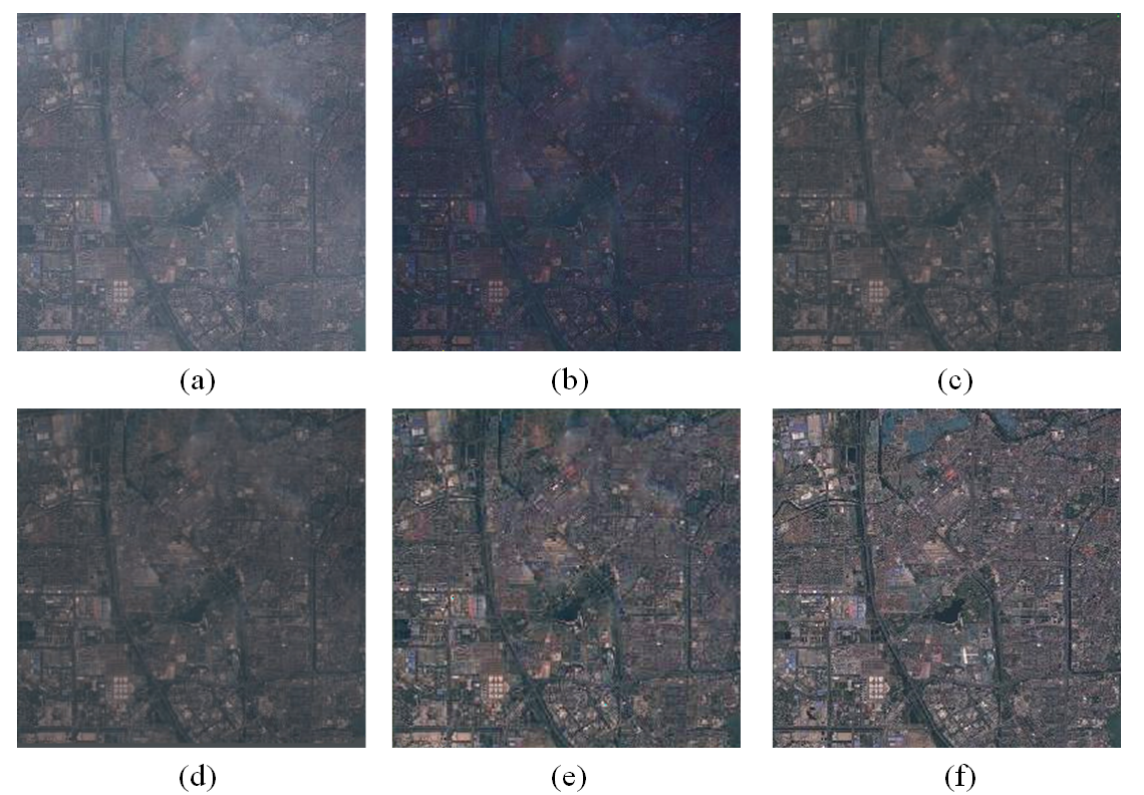
Figure 14. Thin cloud removal results of various methods on a cloudy image from the Sentinel-2A test set: ( a ) input cloudy image, ( b ) result of DCP, ( c ) result of McGAN, ( d ) result of RSC-Net, ( e ) result of our method, and ( f ) reference cloud-free